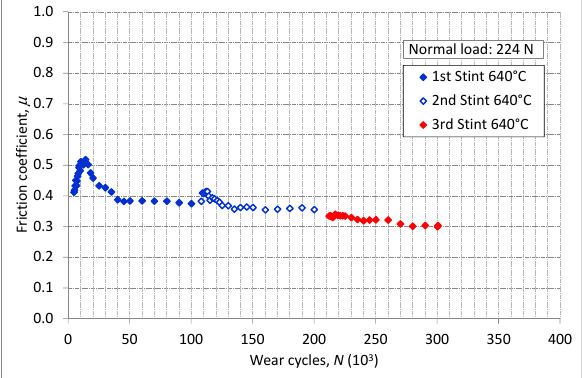
Figure 8. Friction coefficient measure with test rig flat on flat surface [23,24].